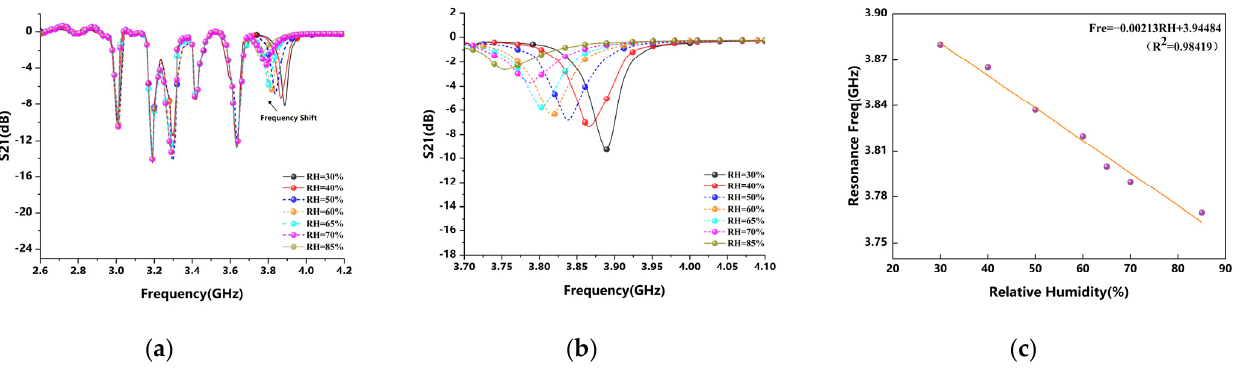
Figure 10. Resonant response of ELC humidity sensor unit: ( a ) Changes in the overall S21 resonant response curve of the tag sensor; ( b ) Change in the S21 curve of locally amplified ELC resonant element; ( c ) Linear fitting line of relative humidity of ELC resonant element.